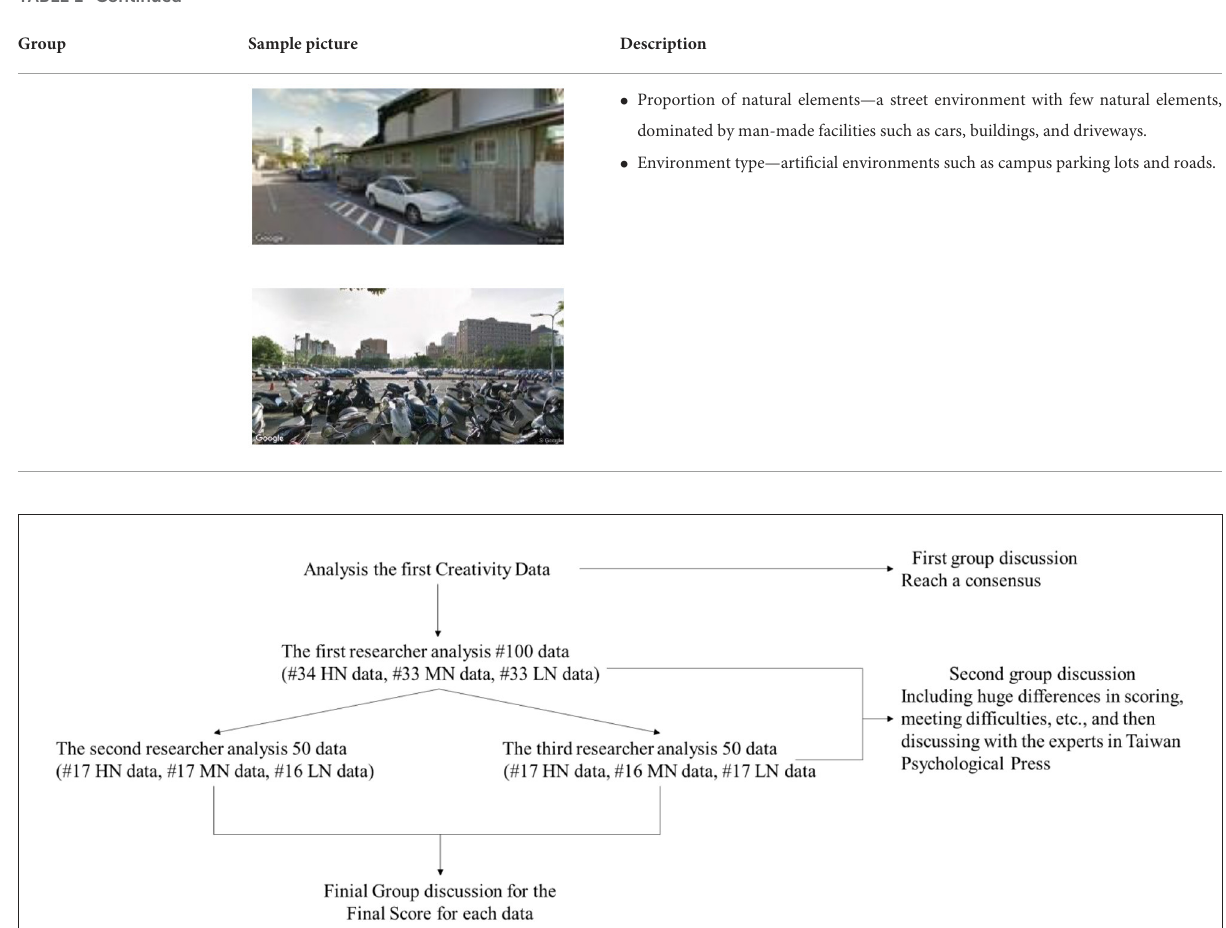
FIGURE1 The scoring process among three researchers. High naturalness (HN), Medium naturalness (MN), Low naturalness (MN); # means numbers of